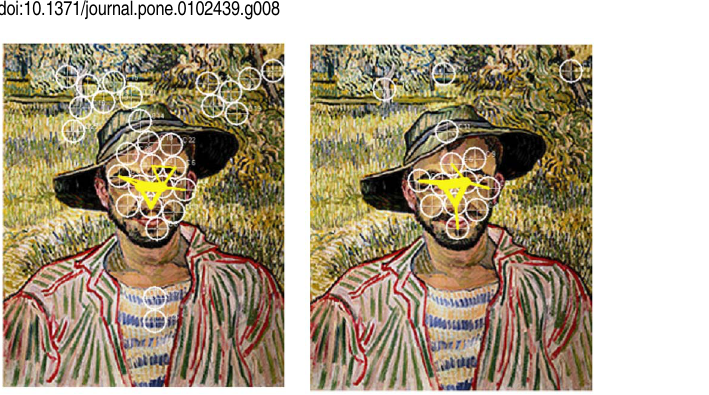
Fig. 9. Speaking effects on frequently repeated transitions between fixation clusters – van Gogh. Left side: Frequently repeated transitions between fixation clusters of the experimental group during minute 11 to 15. Cluster size: 20 mm. Right side: Frequently repeated transitions between fixation clusters of the control group during minute 11 to 15. Cluster size: 20 mm.